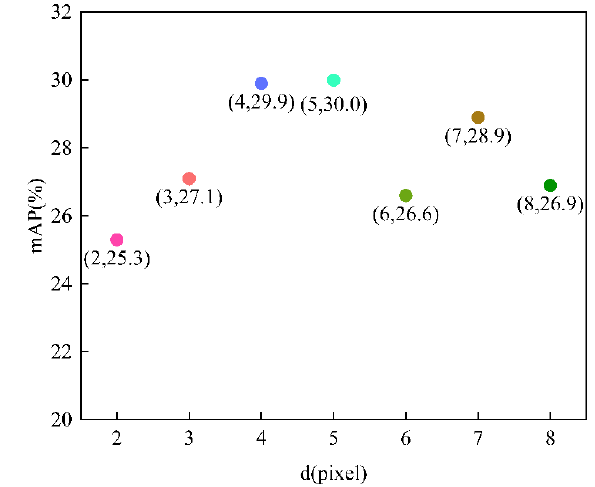
Figure 12. Variation of mAP of the model with d.